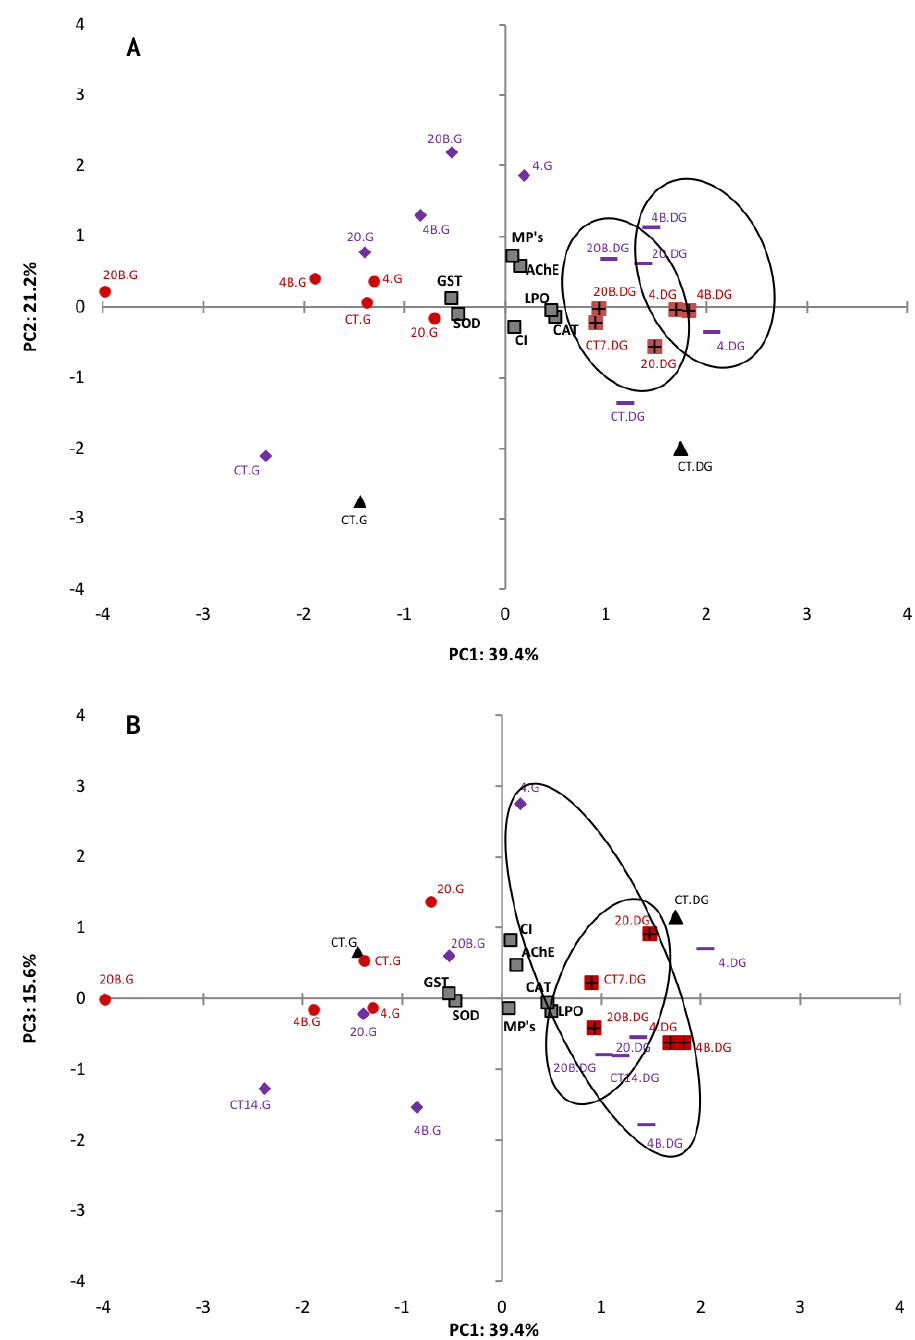
Figure 3. PCA of biomarkers (SOD, CAT, LPO, AChE and GST) in the gills (G) and digestive gland (GD) of the clam S. plana , exposed with different sizes of LDPE MPs with (4–6 µ m (4) and 20–25 µ m (20)) and without BaP adsorbed at different times of exposure (T0 (black), T7 (red) and T14 (purple)) ( A ) PC1 and PC2 components, ( B ) PC1 and PC3 components ( p < 0.05).